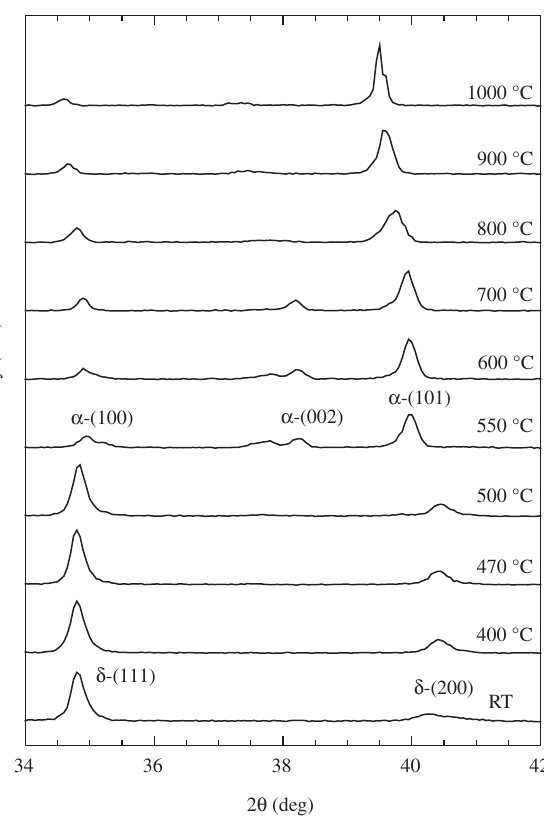
Figure 4. X-ray diffractograms showing the evolution of δ -to- α phase trans- formation as a function of